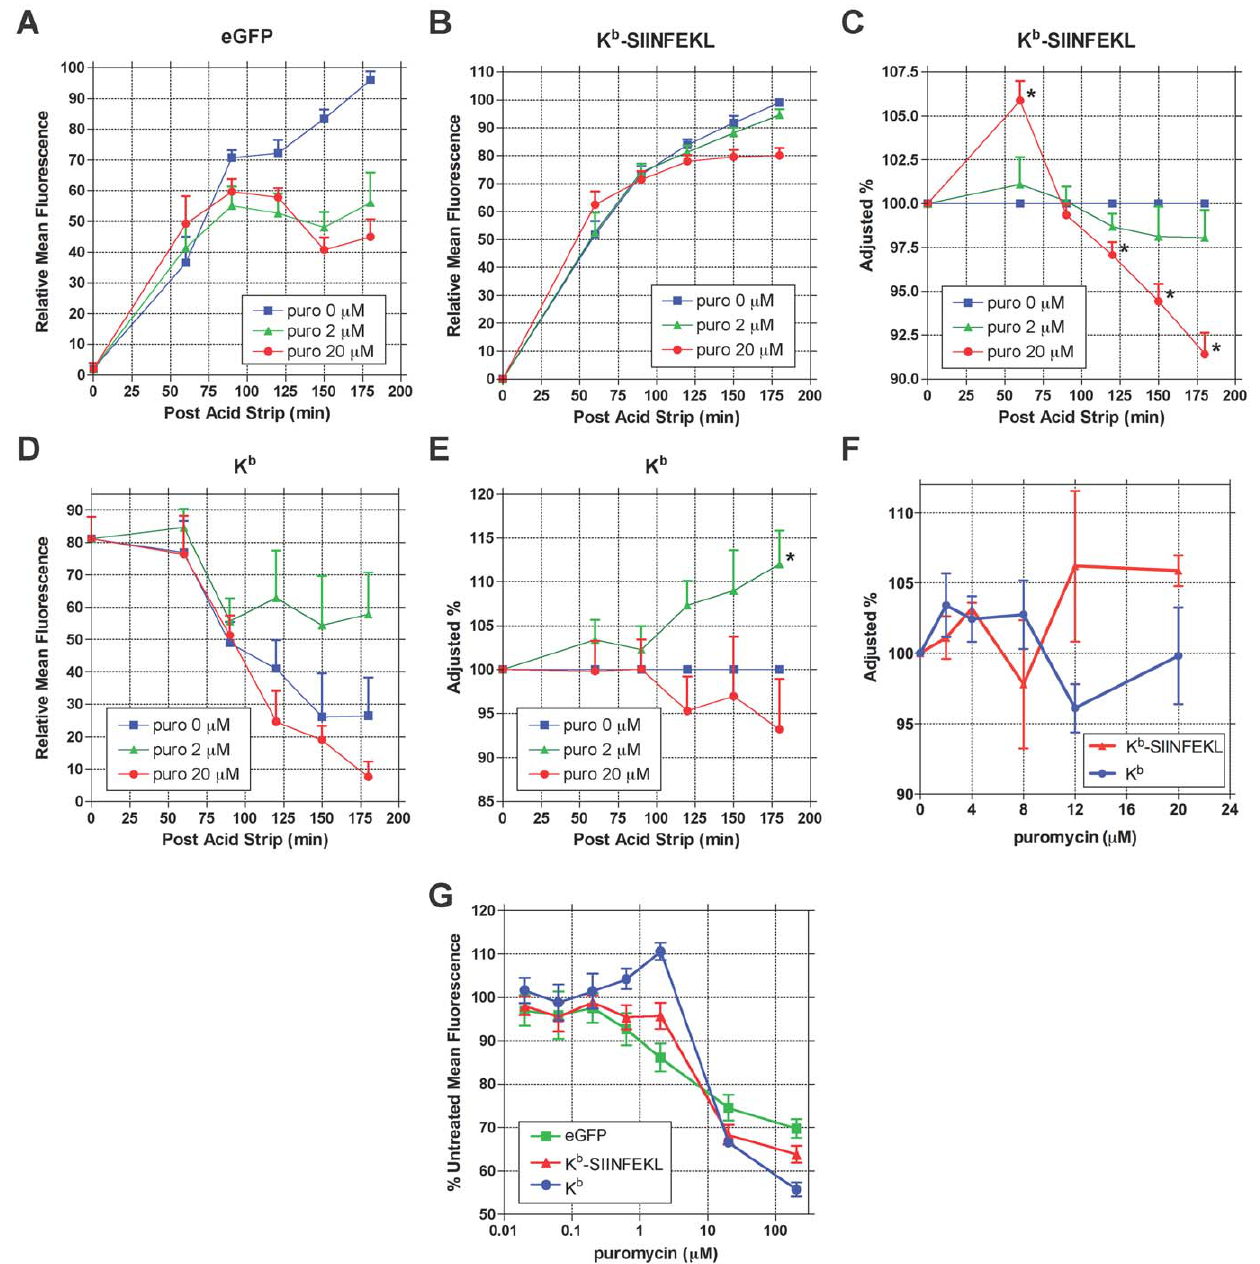
Figure 6. Effects of puromycin on the recovery of cell surface MHC class I-peptide complexes. A – E . 293-K b cells expressing the TRx9 reporter were stripped of cell surface MHC I peptides as in Fig. 5. Recovery of cell surface MHC class I-peptide complexes was conducted in the presence of varying concentrations of puro from 0 to 180 minutes. Flow cytometry was used to measure reporter eGFP fluorescence ( A ), as well as cell surface K b -SIINFEKL complexes ( B ) and total cell surface K b ( D ). To quantitate differences in the kinetics of MHC class I-peptide complex recovery, we normalized the MFI values of puro-treated cells to untreated cells for K b -SIINFEKL ( C ) and total K b ( E ) as described in [4] ( n =5; mean 6 s.e.m.) For C and E , * p , 0.05 compared to untreated samples. F. MHC class I-peptide complex recovery after 1 hour in the presence of varying concentrations of puromycin. MFI values are normalized to untreated cells ( n =3; mean 6 s.e.m.) G . MHC class I-peptide complex recovery after 4 hours in the presence of varying concentrations of puromycin. MFI values are normalized to untreated cells ( n =3; mean 6 s.e.m.).